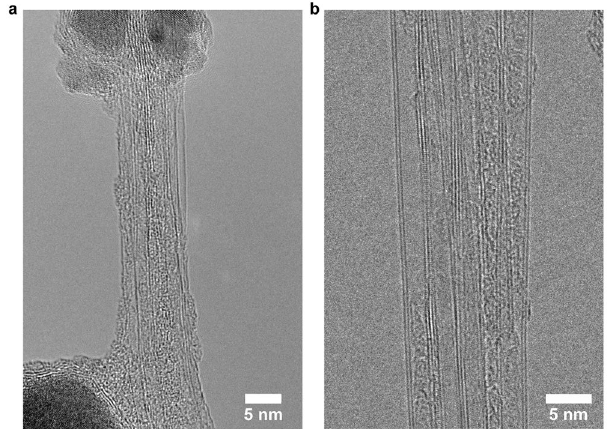
Figure 2. ( a ) Single- and ( b ) double-walled BNNT bundles.